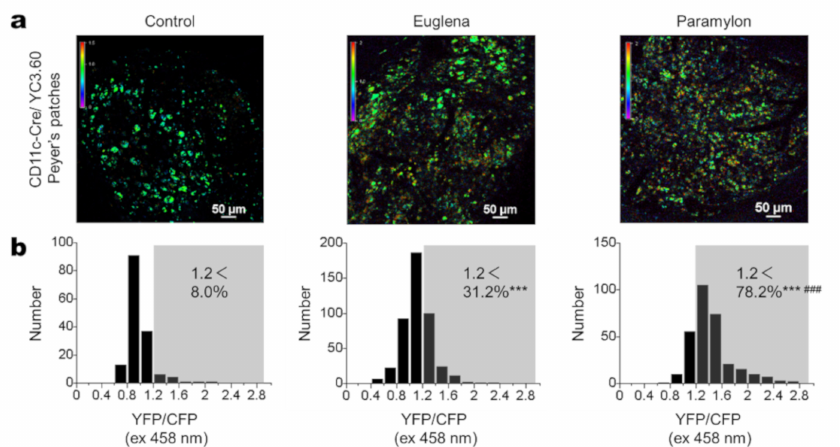
Figure 2. Intravital Ca 2 + signaling in Peyer’s patches (PPs). ( a ) Representative Ca 2 + signaling images of PPs in YC3.60 flox / CD11c-Cre mice intraperitoneally injected with PBS (control, left) Euglena / PBS (center), or paramylon / PBS (right). Intravital ratiometric imaging was carried out 2 hours after injection and shows YFP / CFP excitation at 458 nm. The results are representative of at least three independent experiments ( n = 3 mice; scale bars, 50 µ m). ( b ) Distribution of intracellular Ca 2 + levels in randomly selected cells (control, n = 152; Euglena , n = 455; paramylon, n = 303). YFP / CFP > 1.2 was defined as cells of relatively high Ca 2 + concentration. Pearson’s chi-square test, *** p < 0.001 vs. Control, ### p < 0.001 Euglena vs.